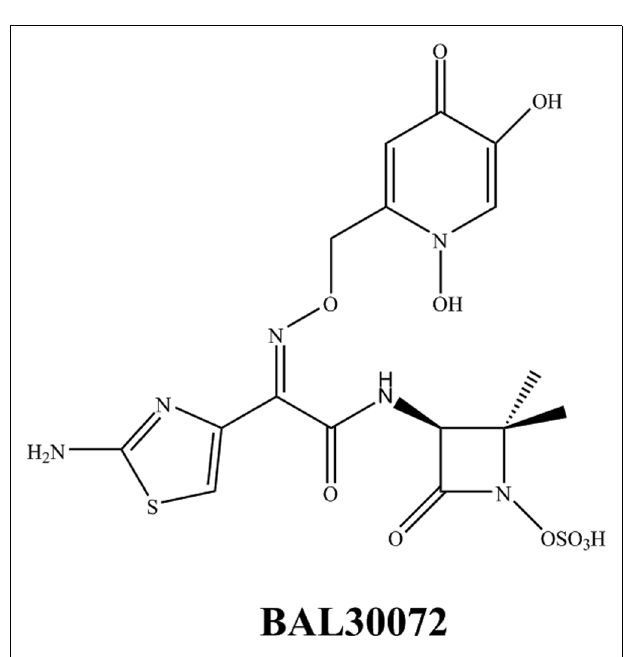
FIGURE 4 | Chemical structure of a novel siderophore monosulfactam